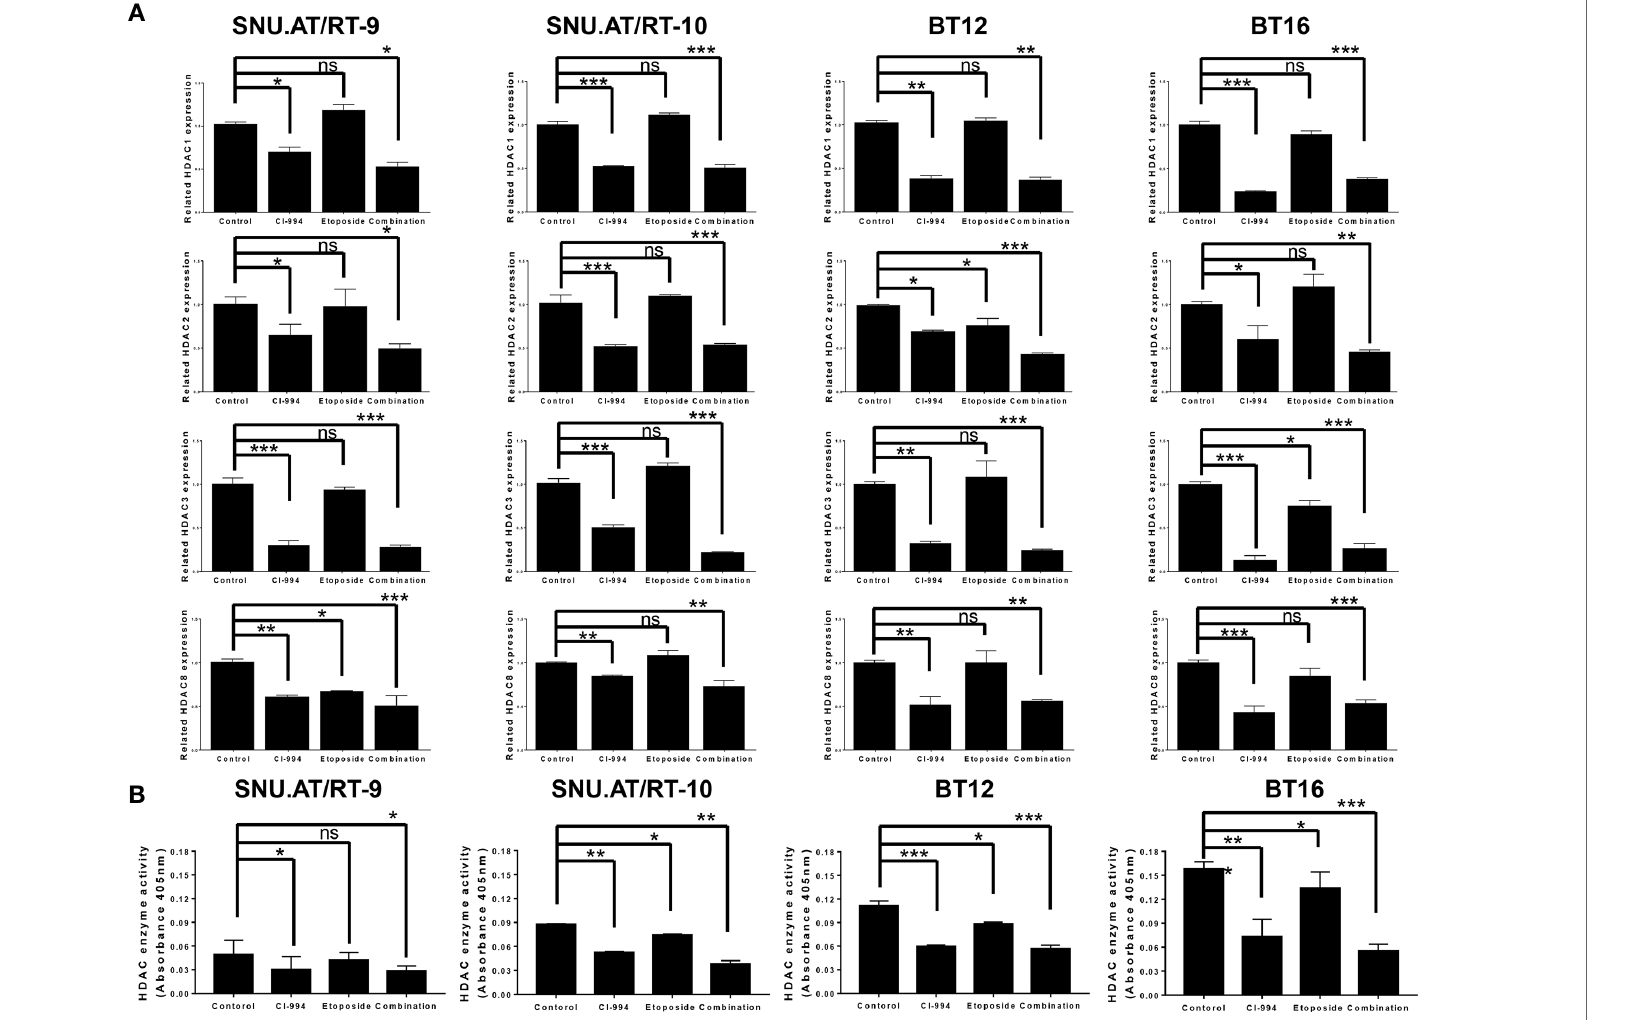
FIGURE 5 | Class I histone deacetylase (HDAC) mRNA expression and HDAC enzyme activity following combination treatment of CI-994 with etoposide. (A) Class I HDAC expression was measured by RT-qPCR in AT/RT cells. Class I HDAC mRNA expression was signi fi cantly reduced by CI-994 treatment in all AT/RT cells. HDAC1 mRNA expression was not affected by etoposide single treatment in all AT/RT cells, but HDAC 2, 3, and 8 expression tended to decrease in some cells. (B) HDAC enzyme activities were signi fi cantly reduced by the CI-994 treatment and combination treatment. Even etoposide single treatment led to a slight decrease in SNU.AT/RT-10 cells, BT12 cells, and BT16 cells, but not in SNU.AT/RT-9. *p < 0.05, **p < 0.001, ***p < 0.0001, ns, not signi fi